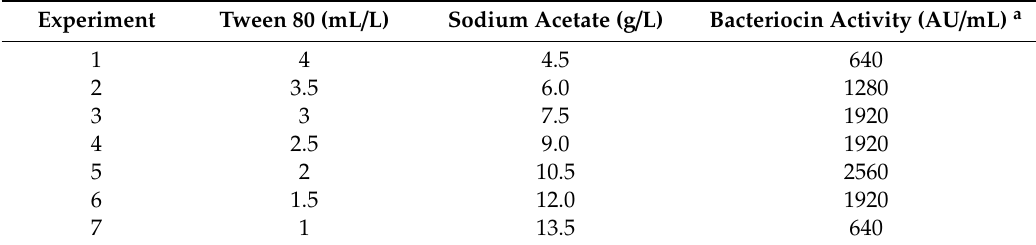
Table 6. The experimental design and results of the steepest ascent experiment.